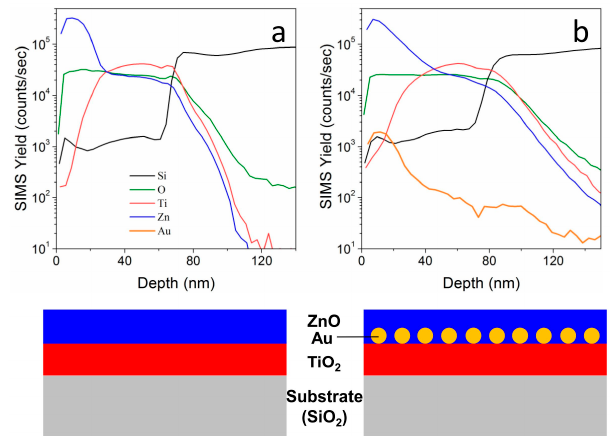
Figure 5. Secondary Ion Mass Spectrometry (SIMS) data showing depth profiles of different ions for ( a ) TiO 2 -ZnO and ( b ) TiO 2 -Au-ZnO thin films. A schematic representation of the respective sample structure is shown at the bottom.